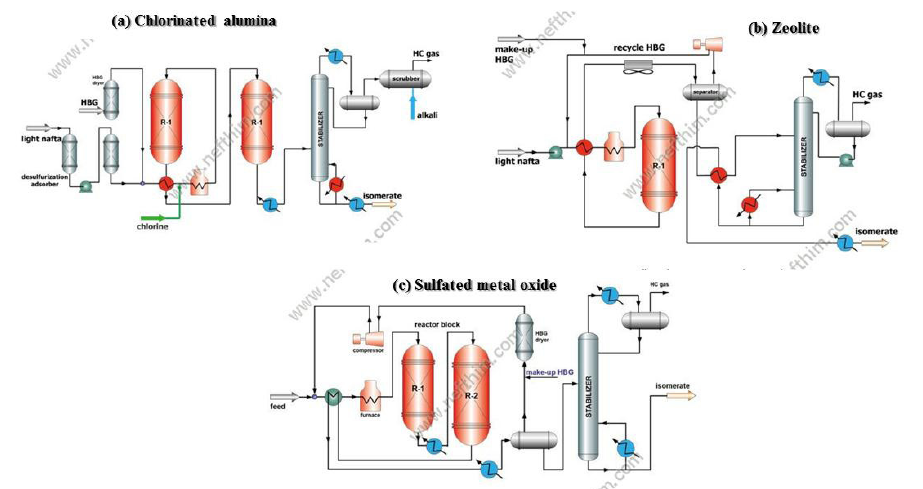
Figure 9. Neftehim technology for C5-C6 paraffins isomerization processes.